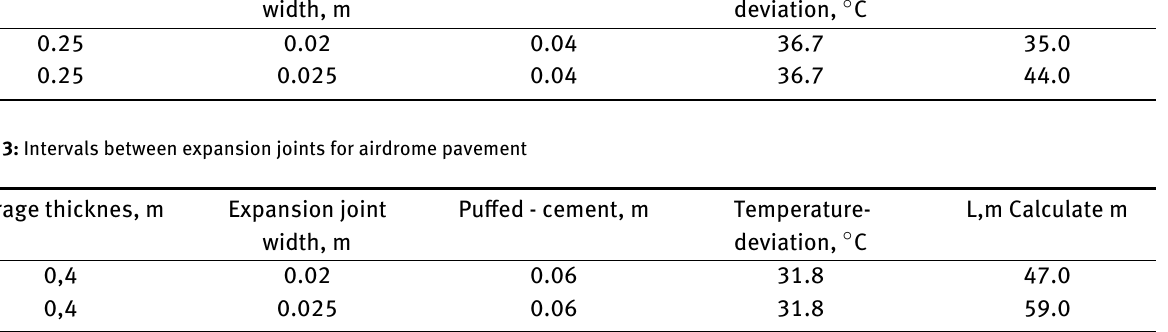
Table 2: Intervals between expansion joints for highway pavement Average thicknes, m